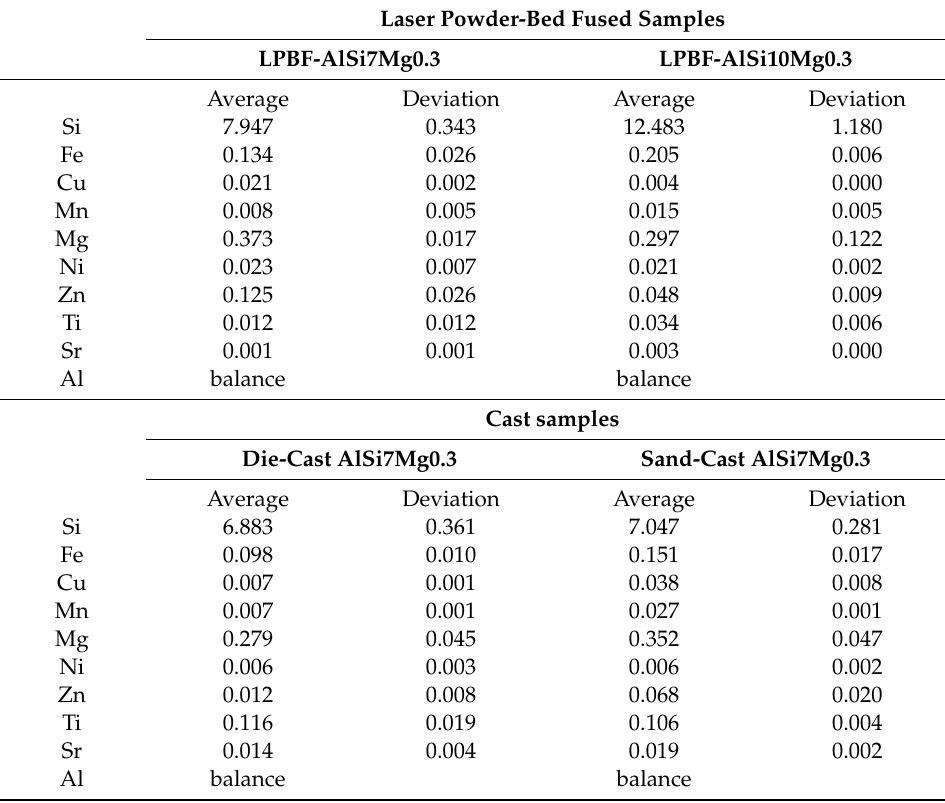
Table 4. Chemical compositions obtained via spark emission spectrometry on laser powder-bed fused and cast samples; all values in